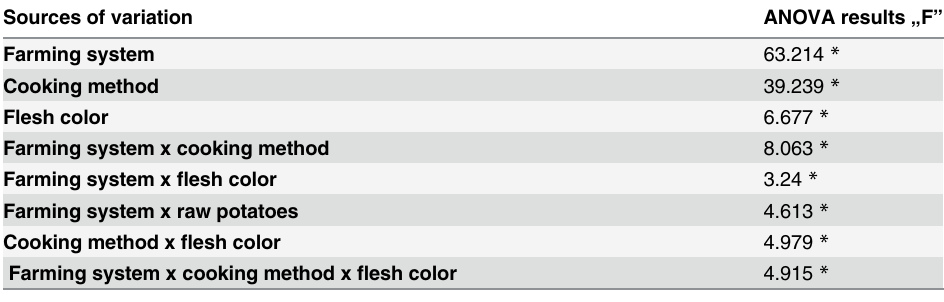
Table 8. Sources of variation and ANOVA results „ F ” for effect of different cooking methods and flesh color on antioxidant activity in potato tubers (see “ Table 7 ”